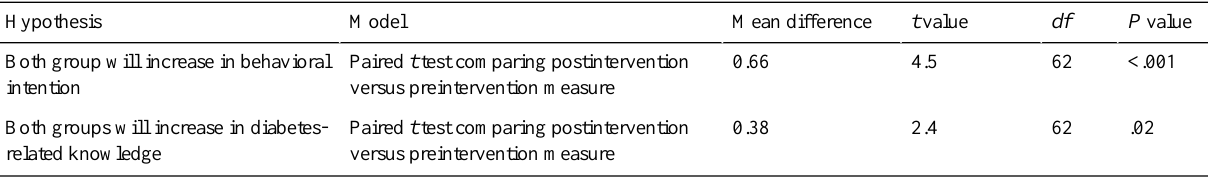
P value dft valueMean differenceModelHypothesis